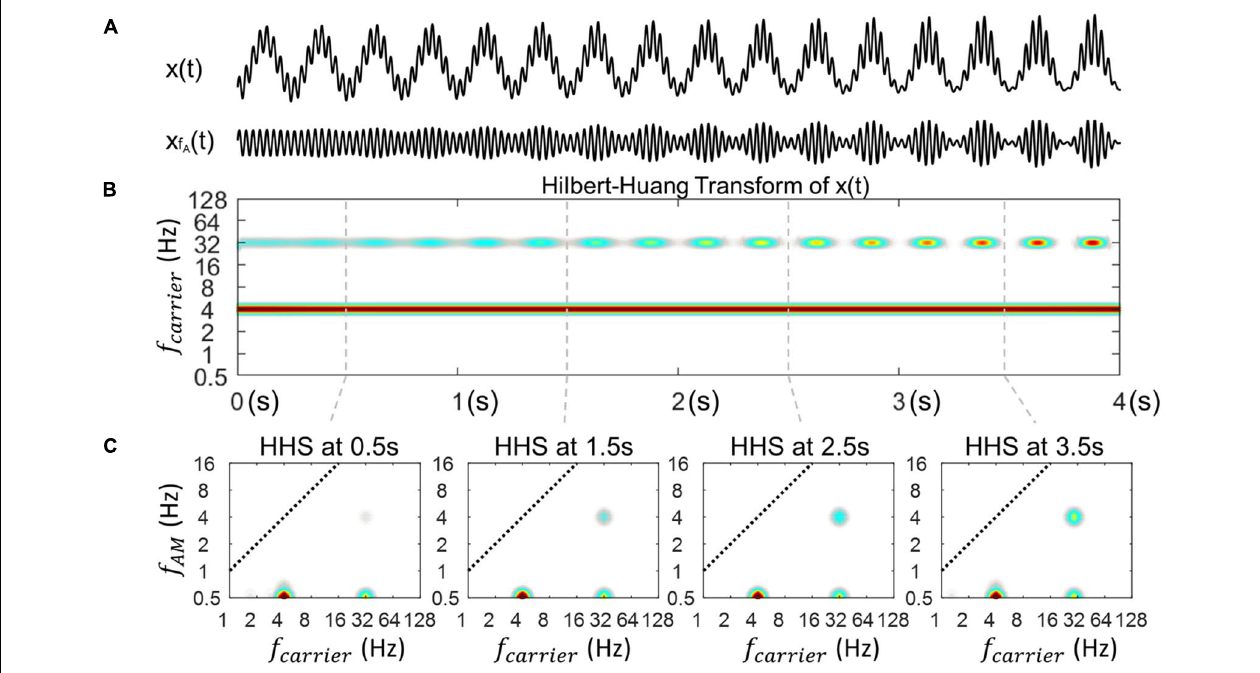
FIGURE 5 | Illustration of the outcome of HHSA on synthesized data with time-varying coupling strength. (A) A synthesized signal X(t) with time-varying coupling strength from 0 to 1. The modulated signal (xf A (t)) shows a power increase corresponding to the coupling strength. (B) The time-resolved power spectrum obtained by Hilbert-Huang transform. (C) The amplitude spectrum of envelope at 4 time points extracted using Holo-Hilbert spectra to track the 4 various levels of coupling strength across